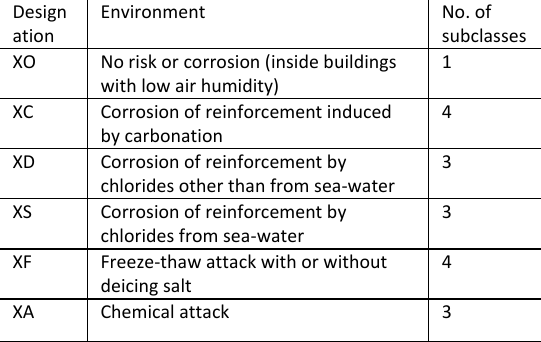
Table 1. Exposure classes in EN206 Design